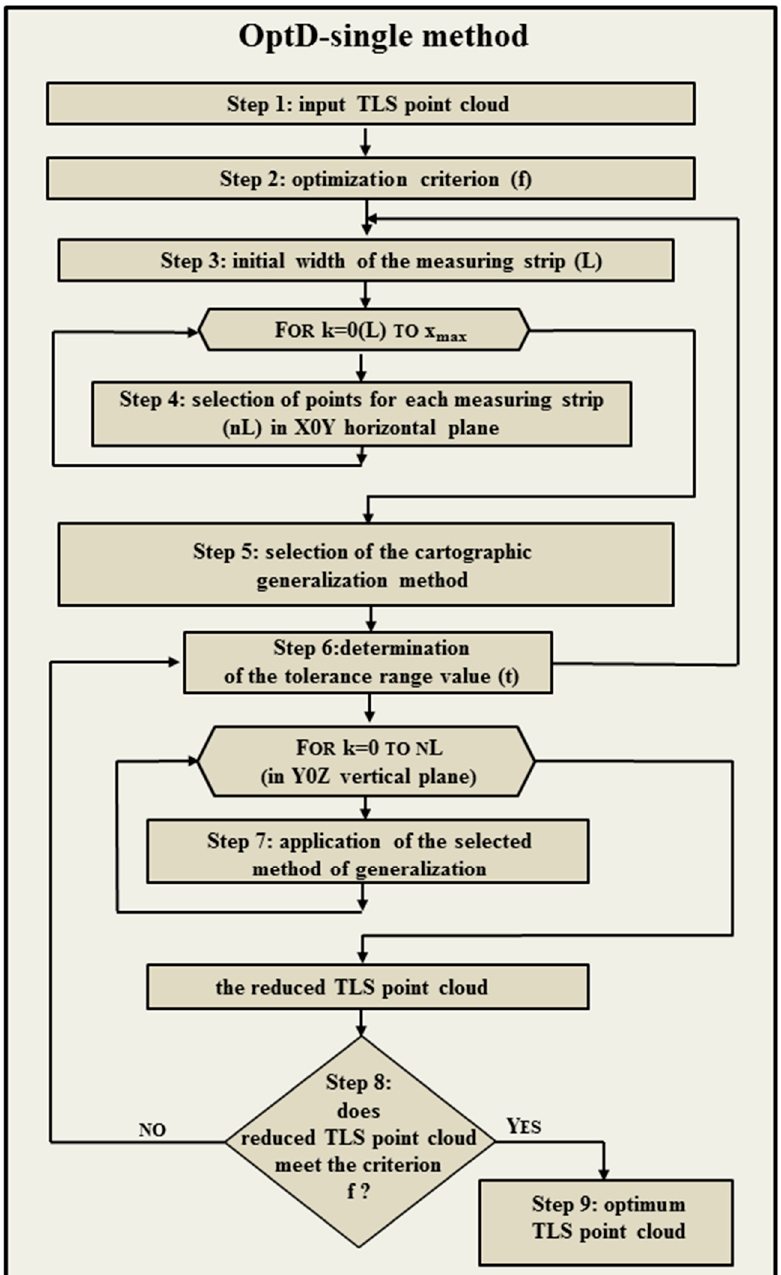
Figure 1. The simplified diagram of the OptD-single methods.